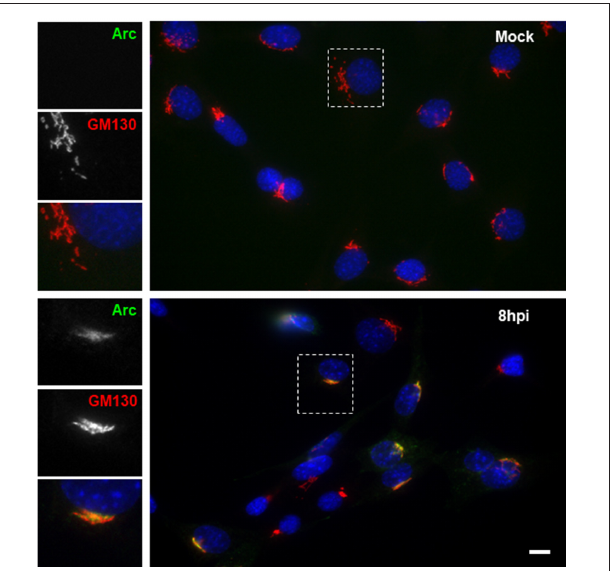
FIGURE 6 | HSV-1 infection induced colocalization of Arc protein with the Golgi marker GM130 in HT22 cells. Untreated (mock) or HSV-1-infected (MOI = 10) HT22 differentiated cells during 8 hpi were stained with antibodies to Arc and the Golgi marker GM130 followed by secondary antibodies coupled to Alexa Fluor 488 and 594 dyes, respectively. Nuclei were stained with DAPI. Scale bar corresponds to 10 µ m. Magnification 630 × . The box inserted shows a zoom capture of the indicated area. The results shown are representative of three independent experiments.